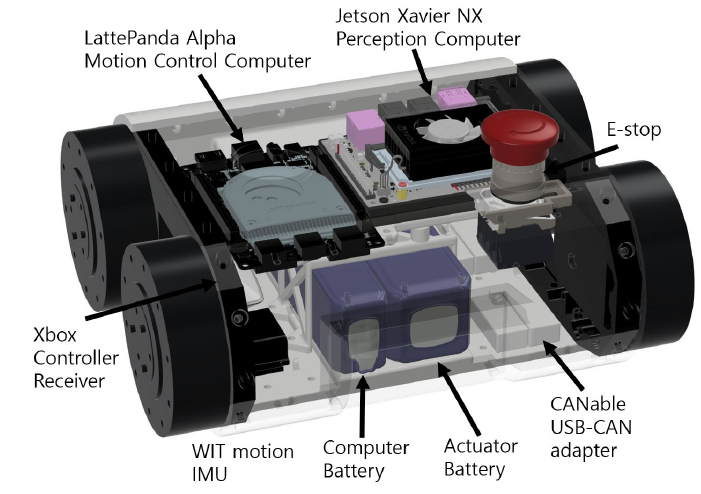
Figure 9. Torso components.